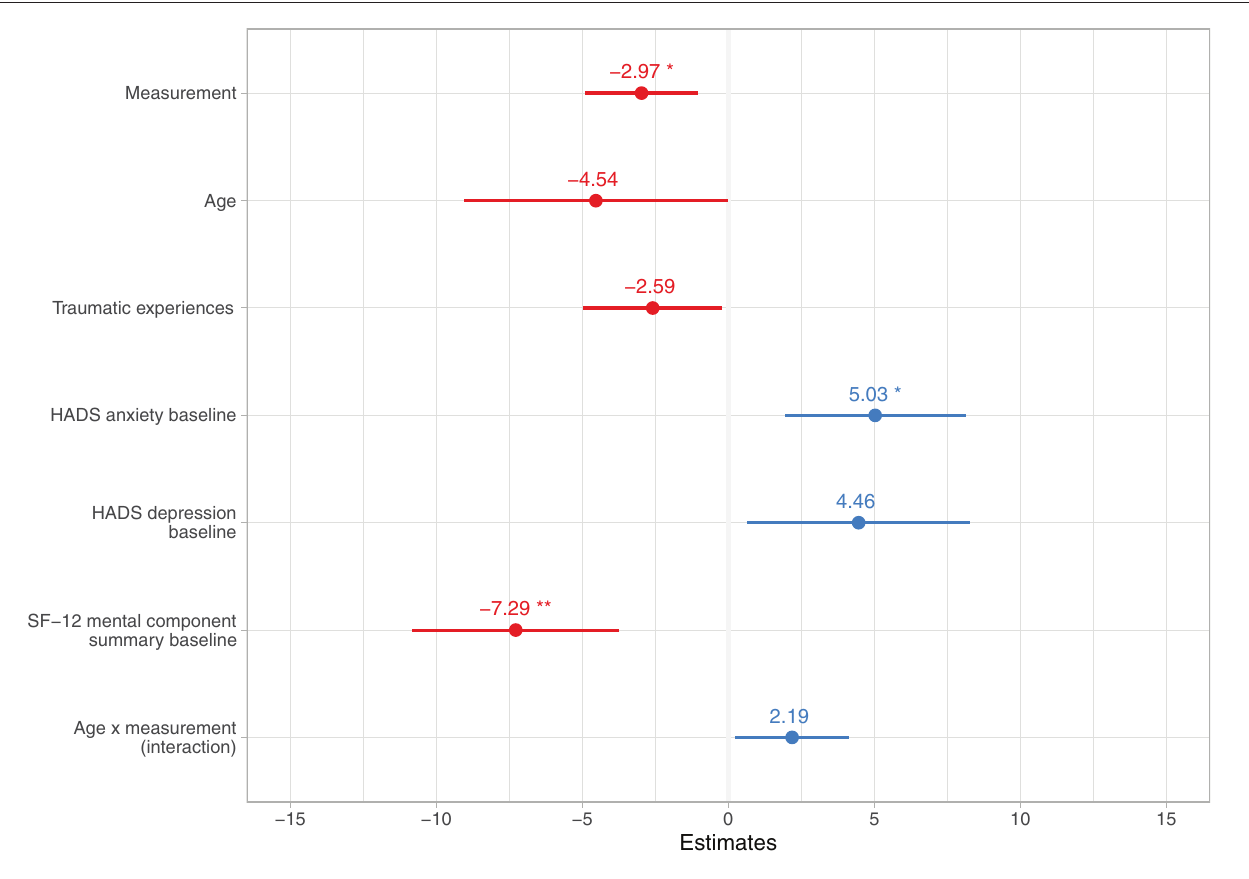
FIGURE 3 | Reduced linear mixed-effects model with stepwise backward elimination for change in Perceived Stress Questionnaire (PSQ-20) scores across baseline, treatment end, and follow-up ( N = 80). Numbers indicate estimated coefficient effects and lines depict 95% confidence intervals. Significance levels are displayed after adjustment for multiple testing with Holm’s method. HADS, Hospital Anxiety and Depression Scale, SF-12, Short Form-12 Health Survey. * p < 0.05; ** p <